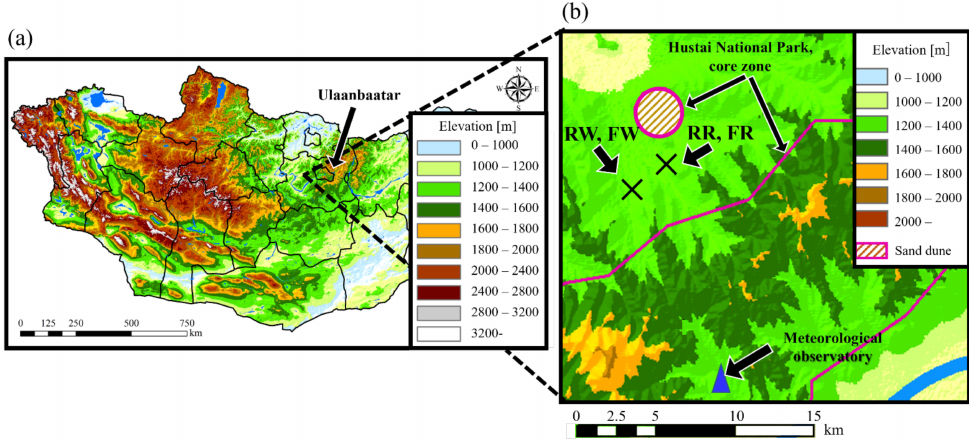
Figure 2. Map of study area. ( a ) Study area located near Hustai National Park, Mongolia and ( b ) Survey sites. FR: rapeseed field; FW: wheat field; RR: rangeland adjacent to FR; RW: rangeland adjacent to FW.